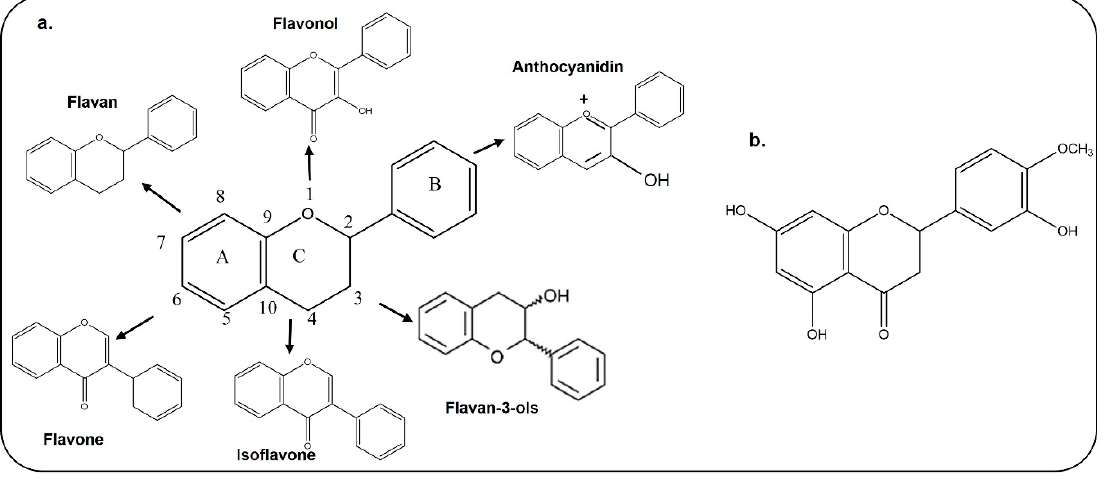
Figure 2. Chemical Structures of different types of flavonoids and hesperetin. a. Chemical structure of flavan, flavonol, flavone, isoflavone, flavon-3-ols, and anthocyanidin. b. Chemical structure of hesperetin.